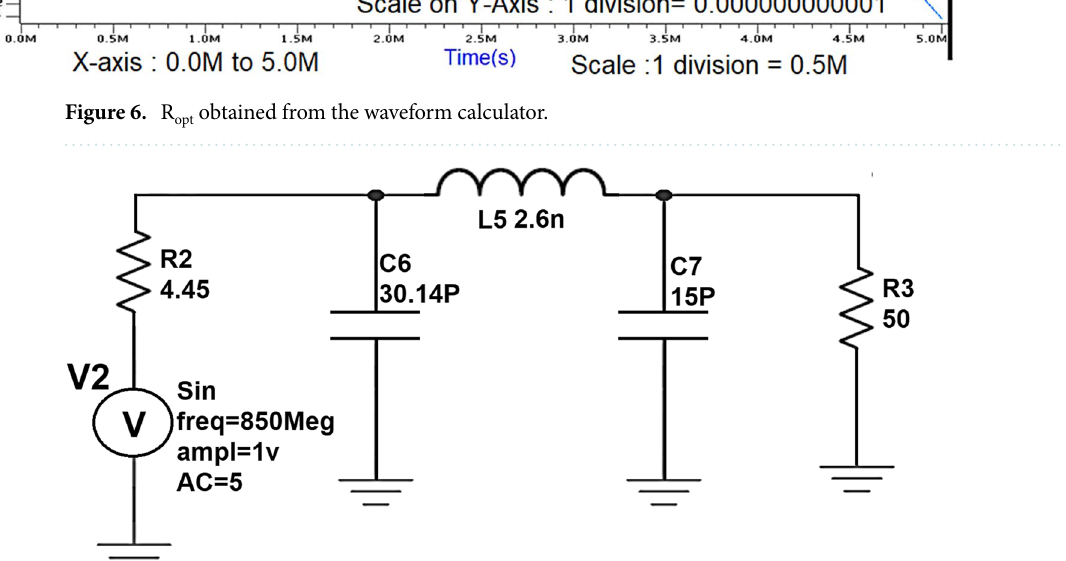
Figure 7. Schematic circuit of the π-type matching